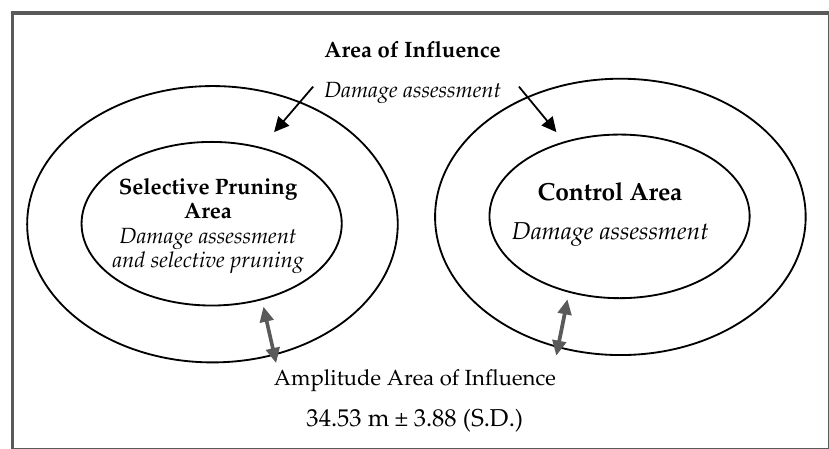
Figure 2. Schematic representation of the different sampling areas and study plots and their respective tasks completed in 2012.